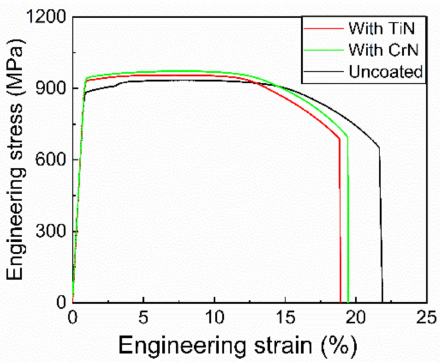
Figure 12. Tensile engineering stress-strain curves of the uncoated sample, CrN, and TiN coated sample.